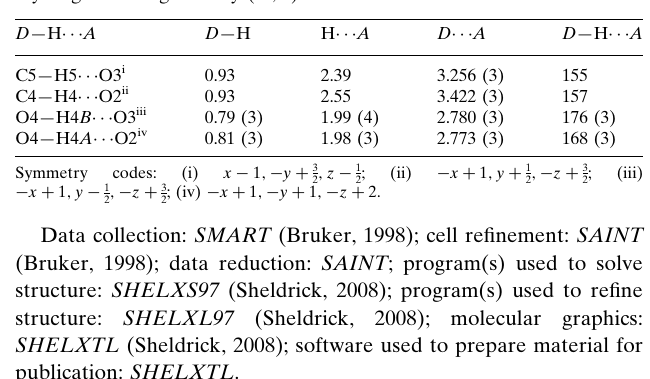
Bruker SMART CCD area-detector diffractometer